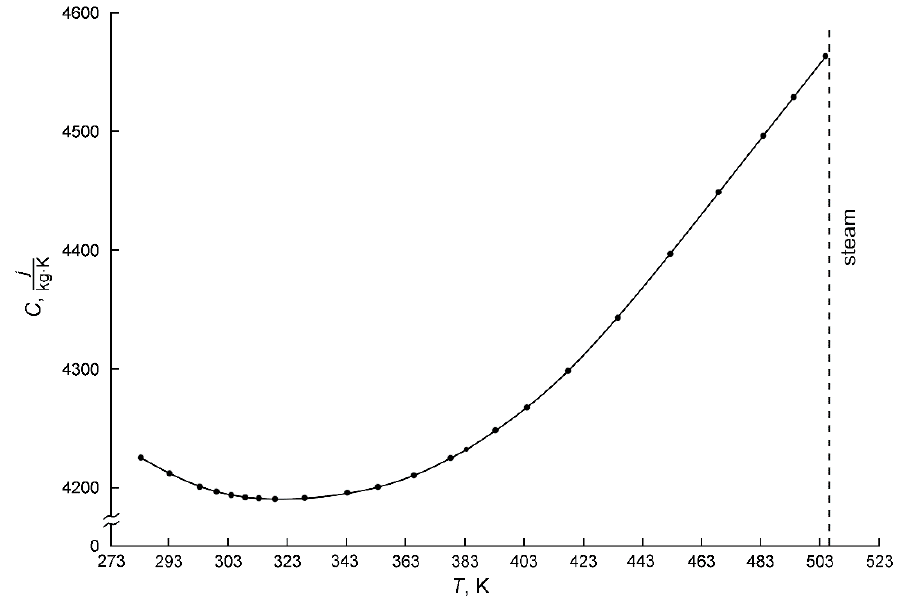
Figure 4. The change in the specific heat capacity C of the feed water on the temperature T . It is possible to construct a calibration curve for the change in the specific heat capacity of feed water C from a change in the refractive index n comparing Figures 3 and 4. Figure 5 shows this dependence.